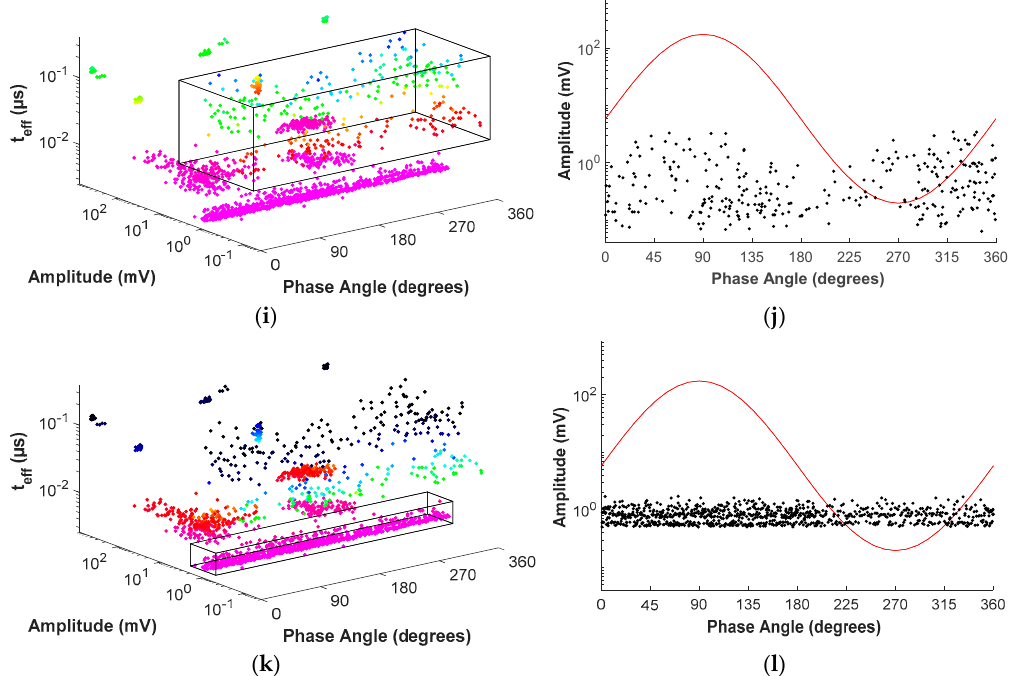
Figure 12. Containers selected superimposed with the PRPD- t eff pattern and classical PRPD patterns for pulses in each container: ( a , b ), corona; ( c , d ), internal PD; ( e , f ), surface PD; ( g , h ), IGBT pulses; ( i , j ), random noise; ( k , l ), electronic noise.